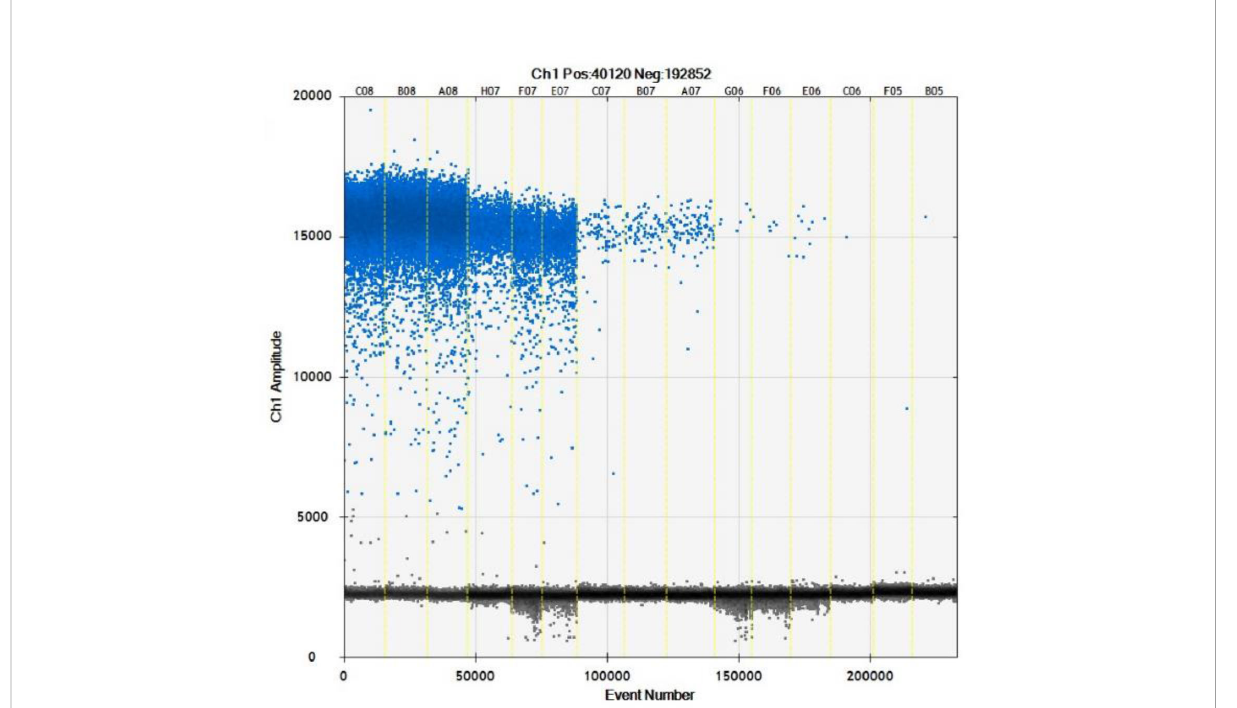
FIGURE 6 Distribution diagram of droplets of T. caries isolates obtained by droplet digital PCR. C08 – A08, DNA template of T. caries (2.4 pg/ m L); H07 – E07, DNA template of T. caries (0.24 pg/ m L); C07 – A07, DNA template of T. caries (24 fg/ m L); G06 – E06, DNA template of T. caries (2.4 fg/ m L), C06 – B05, and DNA template of T. caries (0.24 fg/ m L). The blue dots are positive droplets, and the black dots are negative